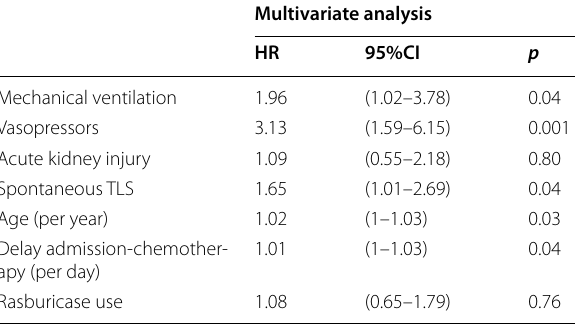
Table 5 Covariates associated with death at one year by